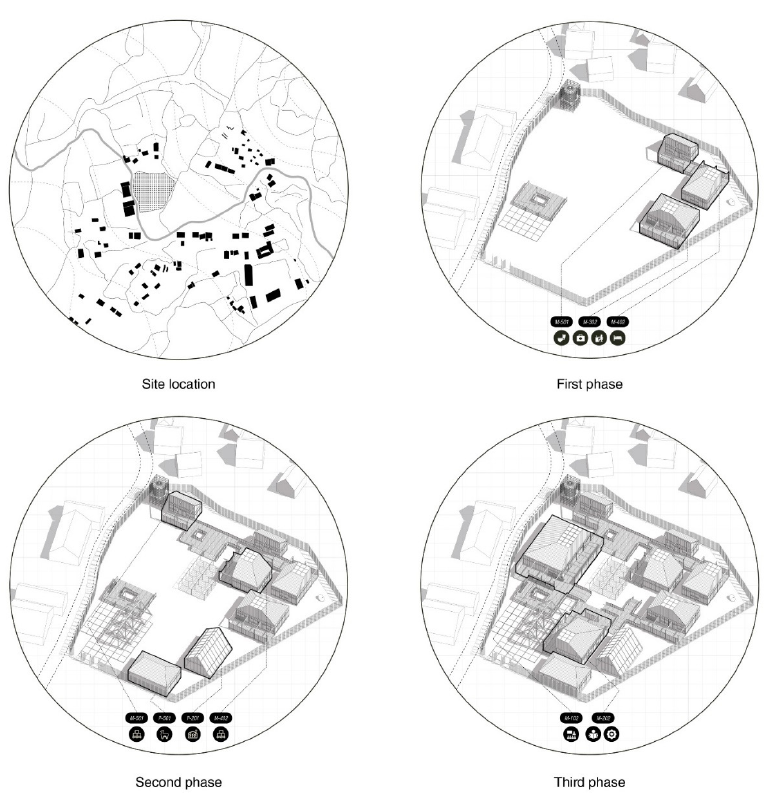
Figure 16. Implementation phases for future tambos (source: